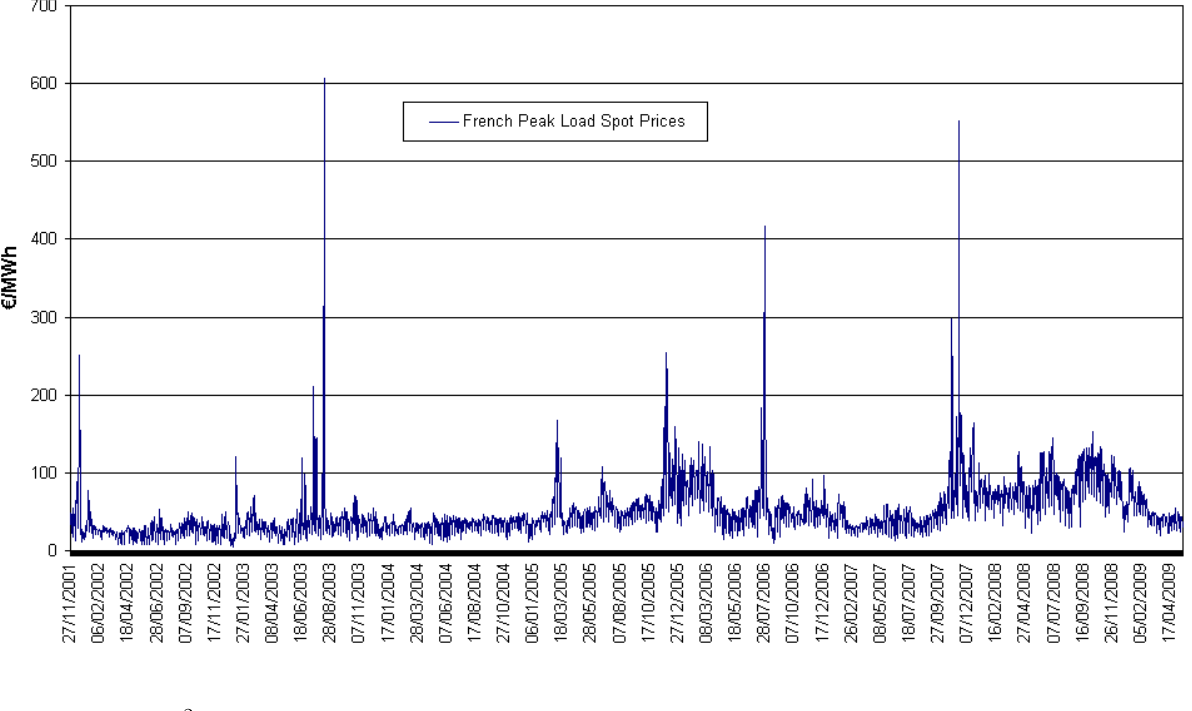
Figure 3. Peak load electricity prices on Powernext